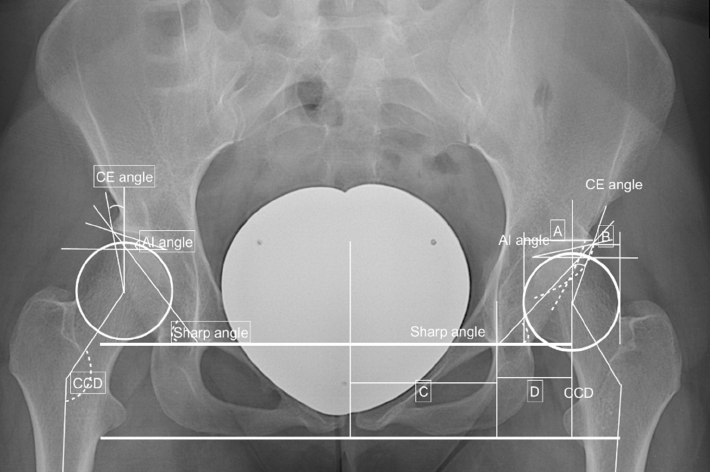
Figure 1. Preoperative findings and measurements performed. Left side: CE angle—between the Perkin line and the line between the center of the femoral head to the lateral edge of the acetabulum − 18.8 ◦ ; AI angle—between the Hilgenreiner’s line and a parallel line to the acetabular roof—12.3 ◦ ; sharp angle—between the horizontal teardrop line and a line connecting the teardrop to the lateral acetabulum—43.9 ◦ ; hip lateralization index—quotient between the horizontal distance of the lateral femoral head that is uncovered by the acetabulum divided by a horizontal width of the femoral head—0.54; anterior hip index—quotient of the femoral head that is covered by the acetabular roof and the width of the femoral head—73.9; CCD angle—between the axis of the femoral diaphysis and the axis of the femoral neck—137.4 ◦ and positive crossing over sign. Adopted from